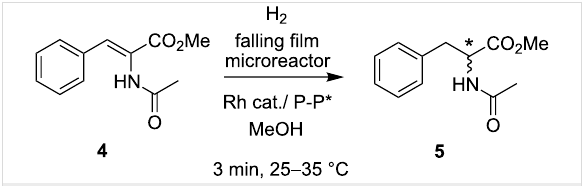
Scheme 2: Asymmetric catalytic hydrogenation in a falling-film